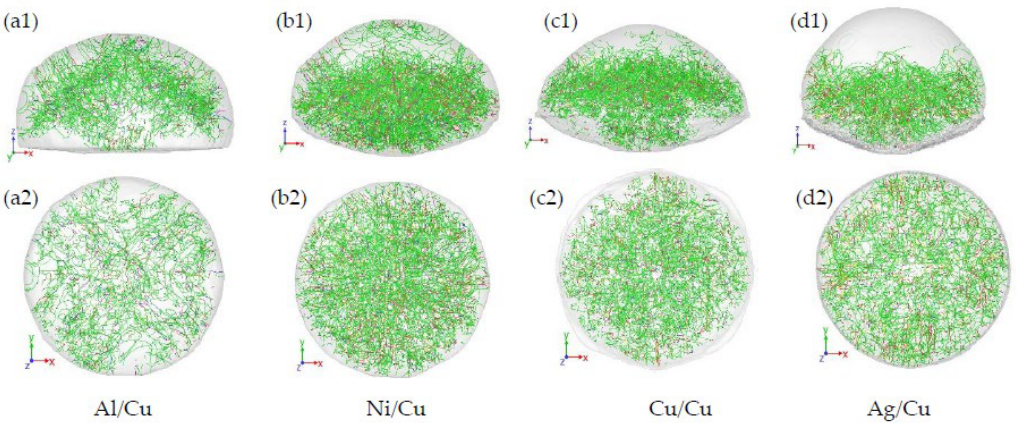
Figure 9. Cross-section view ( a1 – d1 ) and plan view ( a2 – d2 ) for the evolution of dislocation segment in the impacting particles of ( a1 , a2 ) Al/Cu, ( b1 , b2 ) Ni/Cu, ( c1 , c2 ) Cu/Cu, and ( d1 , d2 ) Ag/Cu after cold gas dynamic at 15 ps and 1000 m/s.